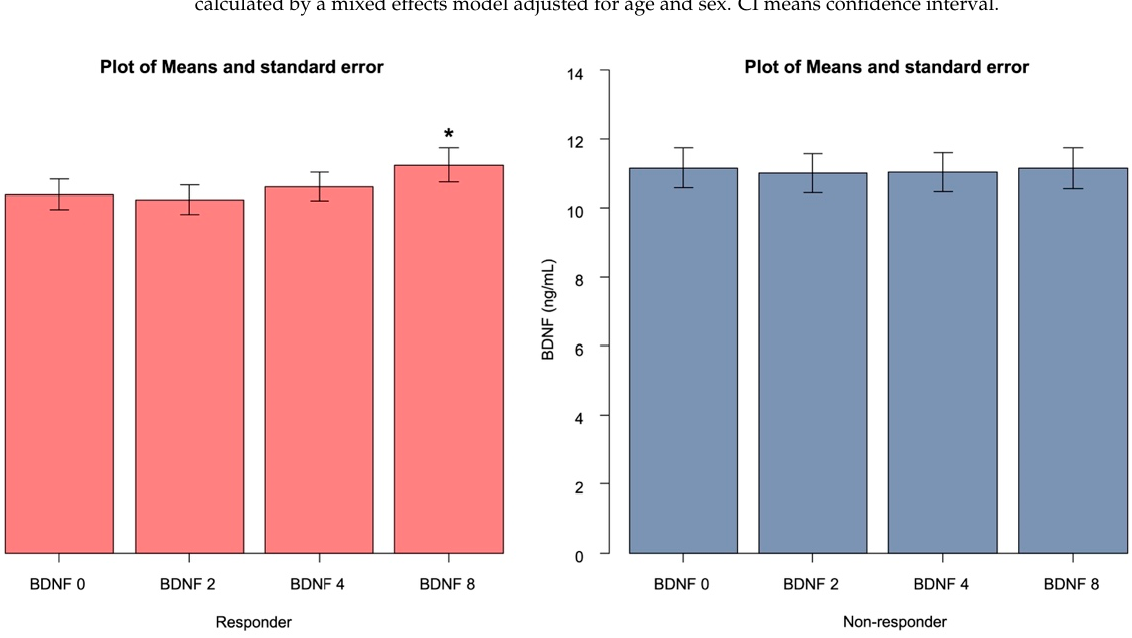
Figure 2. Changes in serum BDNF levels in the responders and non-responders. Data was expressed as mean and standard error.